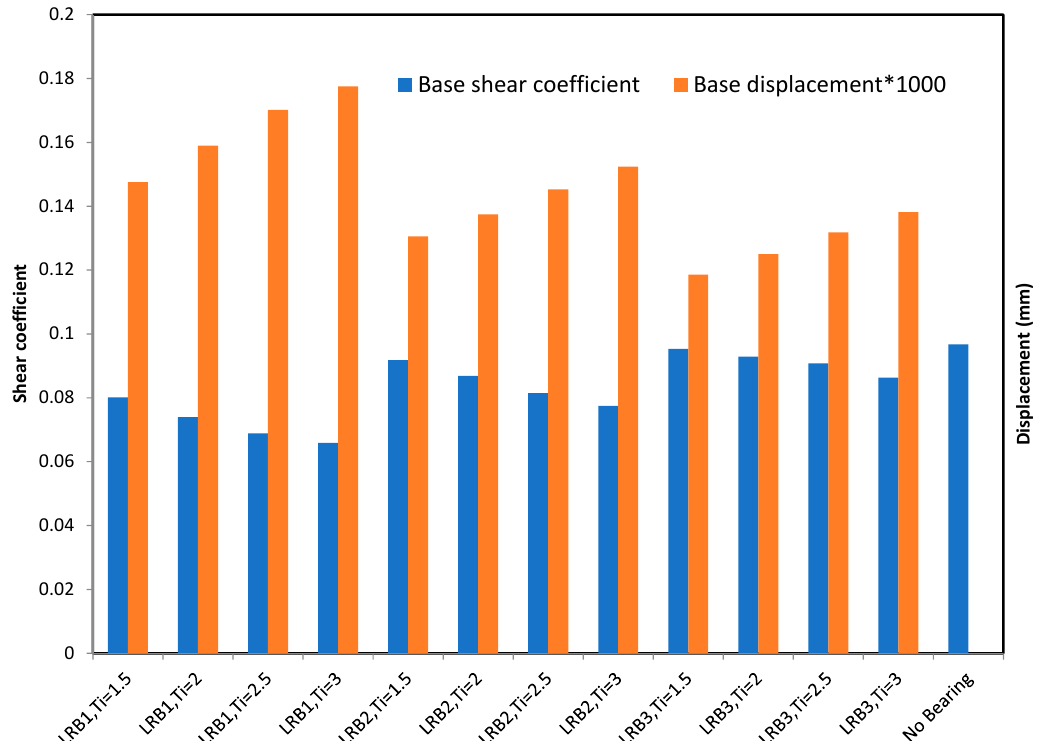
Figure 8. Variation of shear coefficient and displacement at 10-story building base.